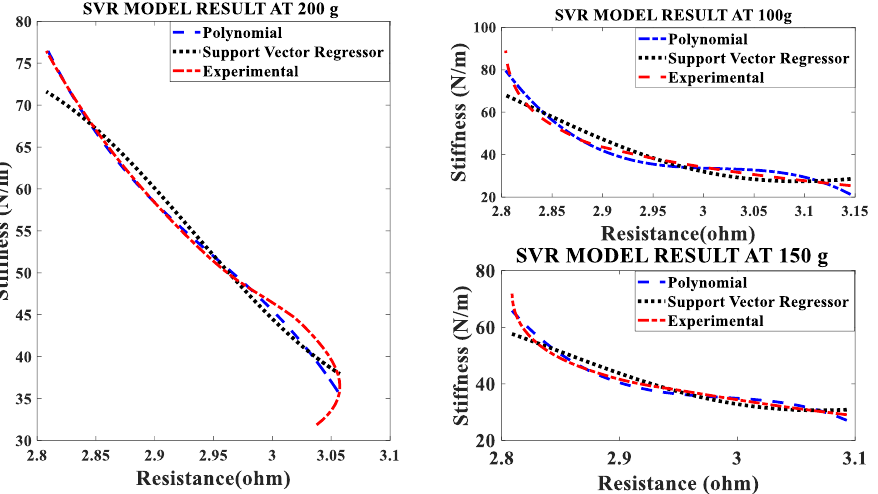
Figure 6. Comparison of Models of Self-sensing Stiffness characteristics with experimental results at different pre-stresses. Table 10. Metrics of inferential models at different pre-stresses.